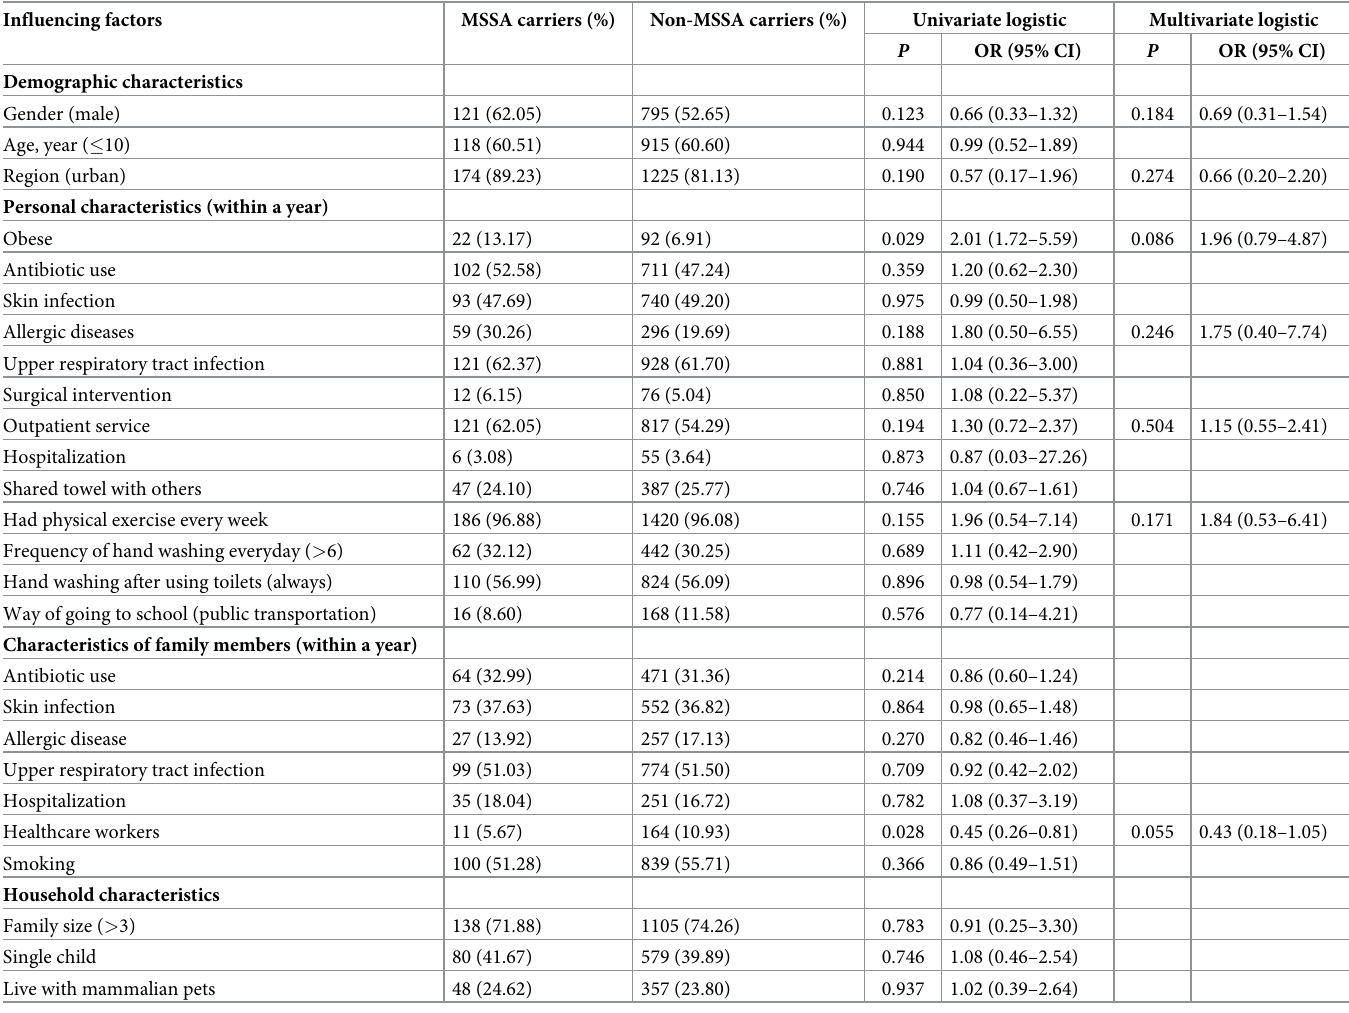
Table 1. Influencing factors of MSSA nasal colonization among elementary students, Guangzhou,